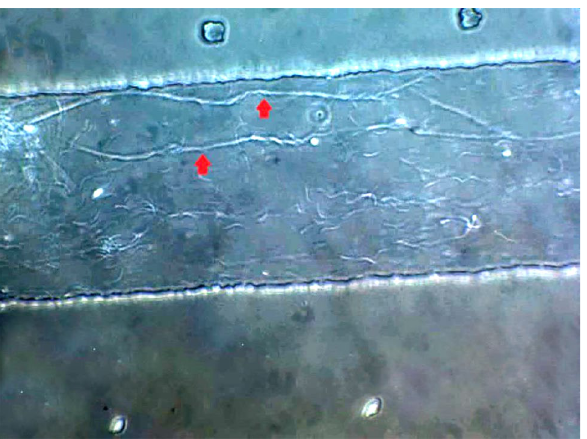
Figure 2. Two Sharkasi sperm thread-like bundles swimming in a dynamic environment parallel to the sidewall of a microfluidic channel of 200 µm × 20 µm dimensions (W × H) under phase contrast microscope. A magnification of (× 400) was